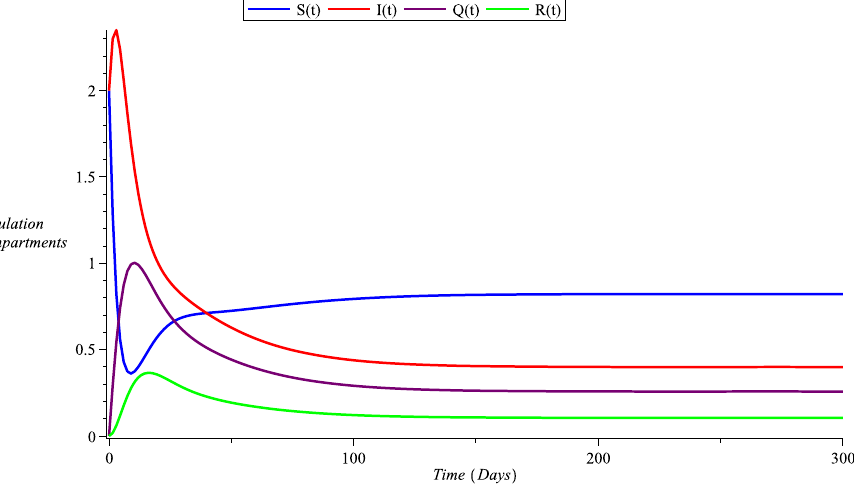
Fig. 5. Time-course solution with relaxed social isolation and total lockdown , σ = 0 . 1 , η = 0 . 0